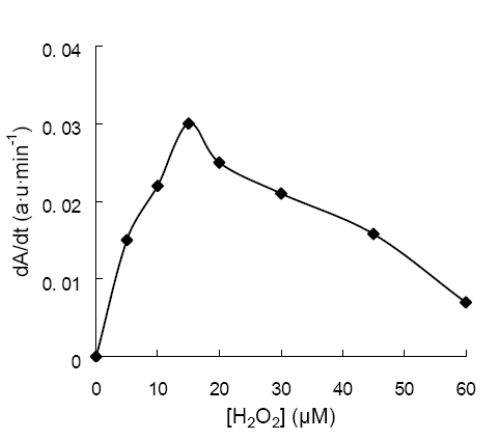
Fig. 2 Effect of the concentration of H 2 O 2 on the initial rate of the LiP catalyzed oxidation of PR. Conditions: [LiP] = 0.1 μ M; [PR] = 40 μ